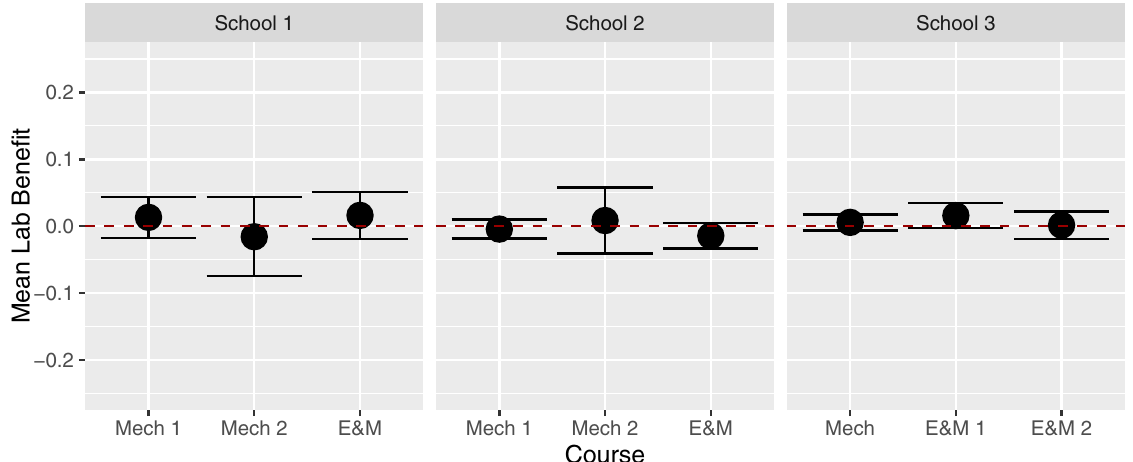
FIG. 1. The mean lab benefit [Eq. (2)] on the final exams in nine courses at three institutions. Error bars represent the standard error ( ¼ standard uncertainty in the mean). The dashed line indicates the hypothesis being tested (whether the mean lab benefit differs significantly from